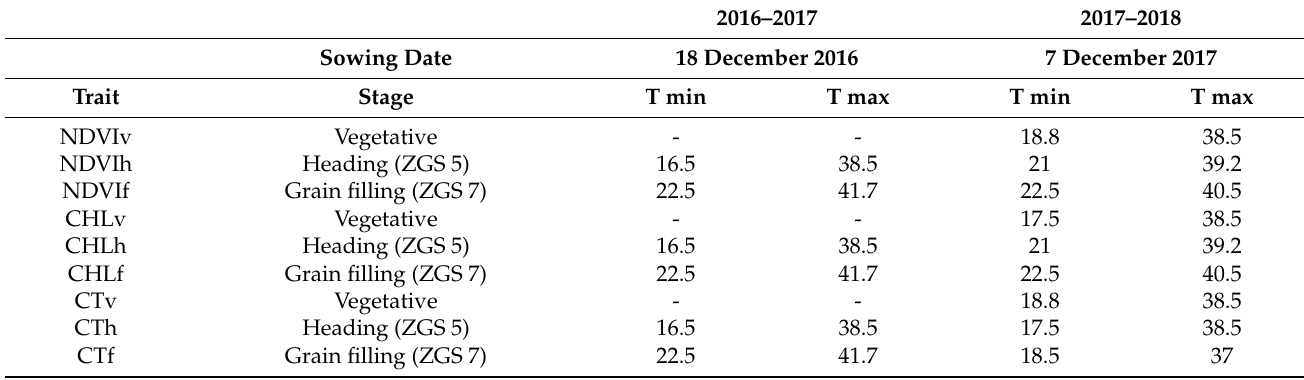
Table 1. Maximum and minimum temperatures during physiological trait records at wad Medani for the two